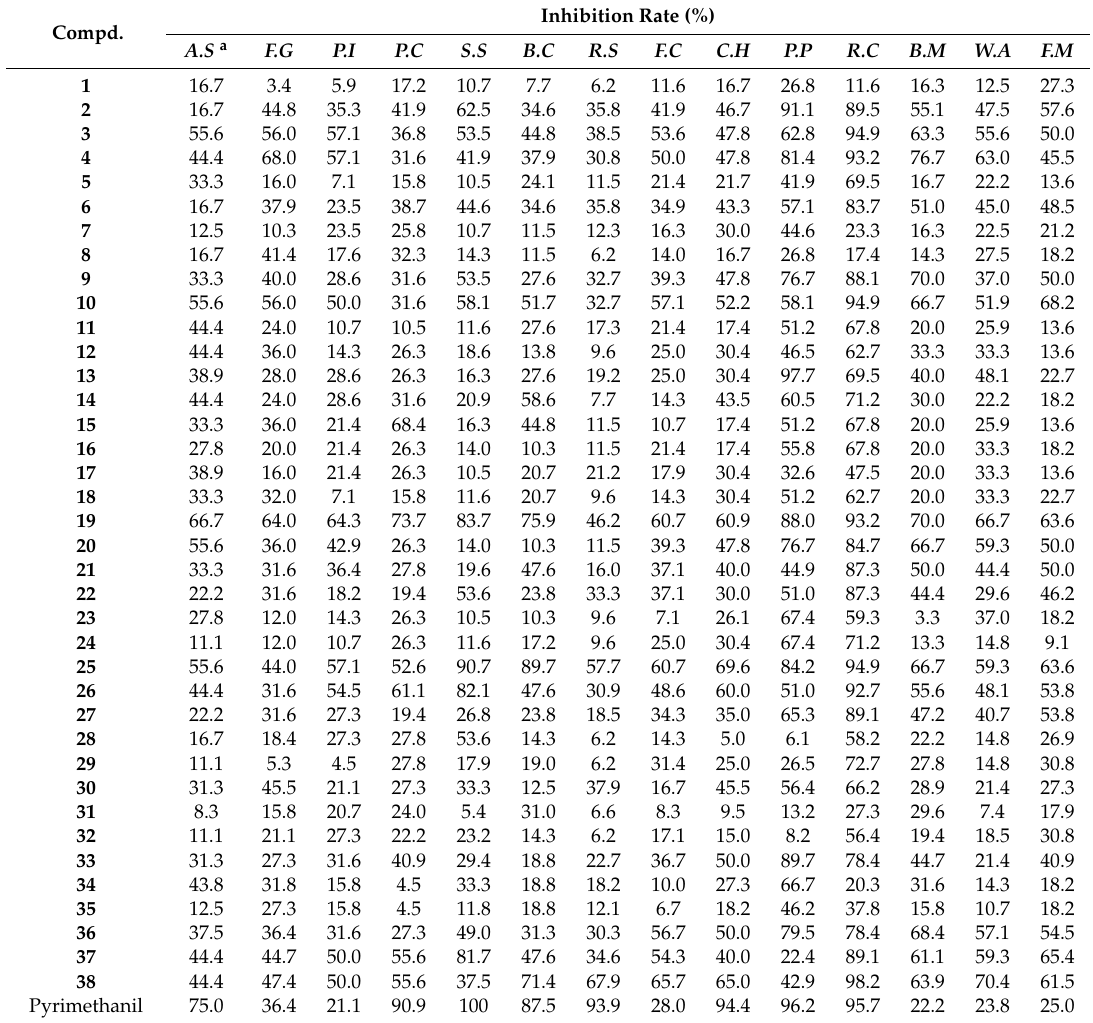
Table 2. Fungicidal Activity of Compounds 1 – 38 against Phytopathogenic Fungi at 50 µ g mL − 1 .